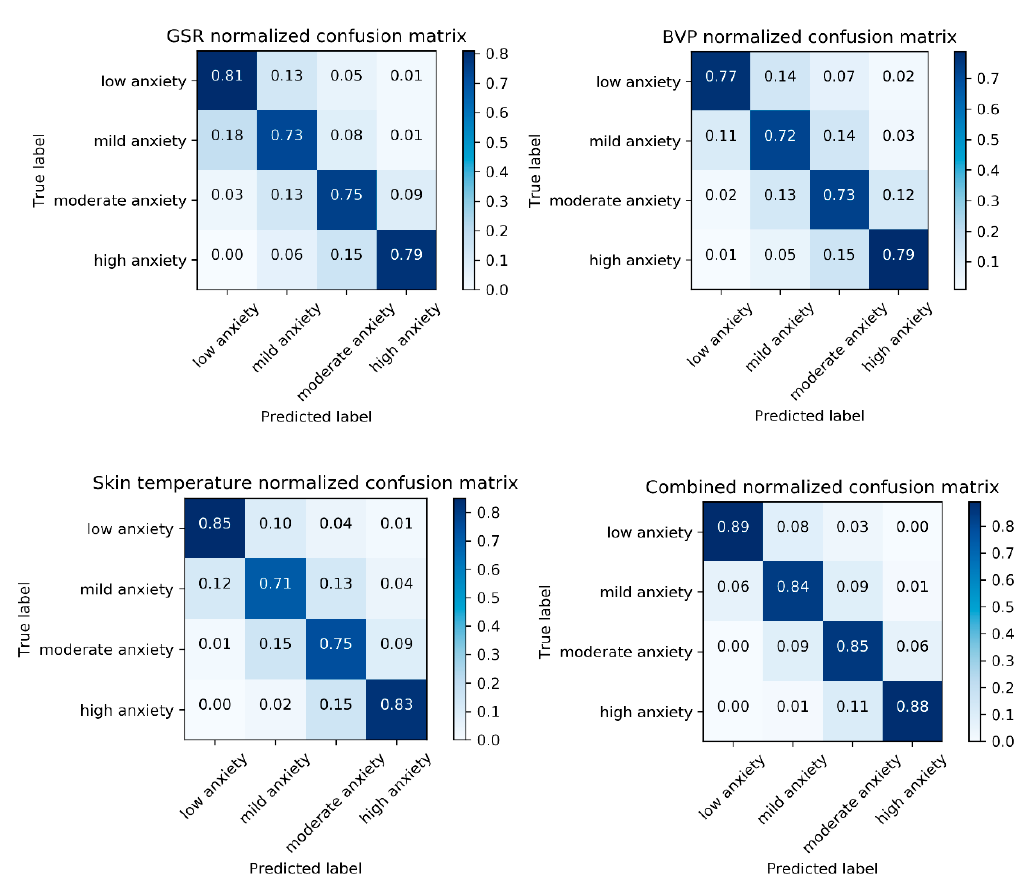
Figure 8. Confusion matrixes for each signal (GSR, BVP, skin temperature) and signal fusion (early).